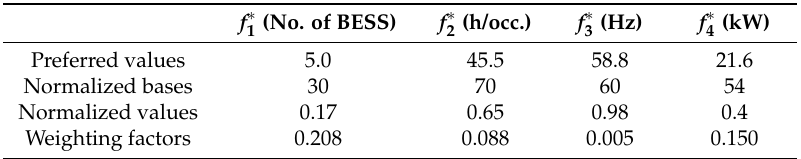
Table 3. Preferred values f ∗ (cid:96) and corresponding weighting factors.